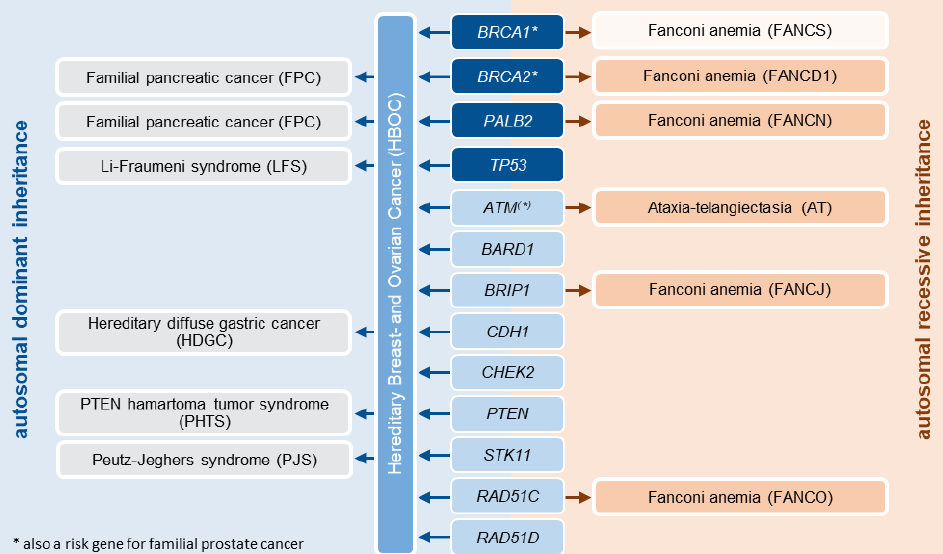
Figure 4. The simplified illustration of the HBOC core genes risk profile during genetic counseling at the institute of human genetics Greifswald does not claim completeness and does not replace a human genetics and interdisciplinary judgement, which depends on the individual genetic variant identified and is presented in the counseling letter and — if necessary — in the genetic board decision. Particularly, additional associated tumor risks (e.g., for CHEK2 carriers [28]) are discussed in detail during the second genetic consultation.